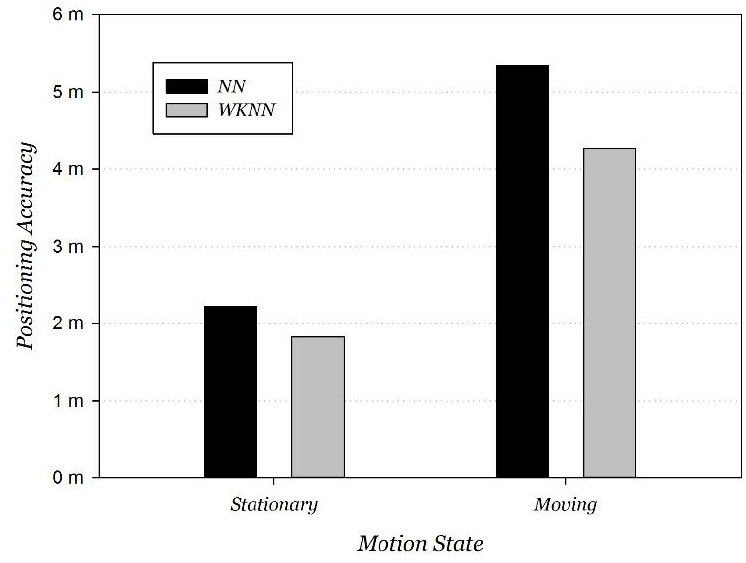
Figure 11. Wi-Fi positioning performance at moving/stationary states.